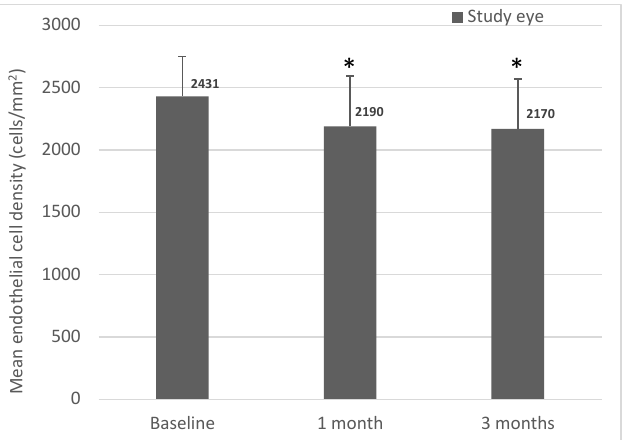
Figure 3. Mean endothelial cell density in study eyes over 3 months. Endothelial cell density was measured preoperatively (baseline) and at postoperative months 1 and 3 ( n = 24). Data are expressed as mean ± standard deviation (* p < 0.05 from baseline, paired t -test).